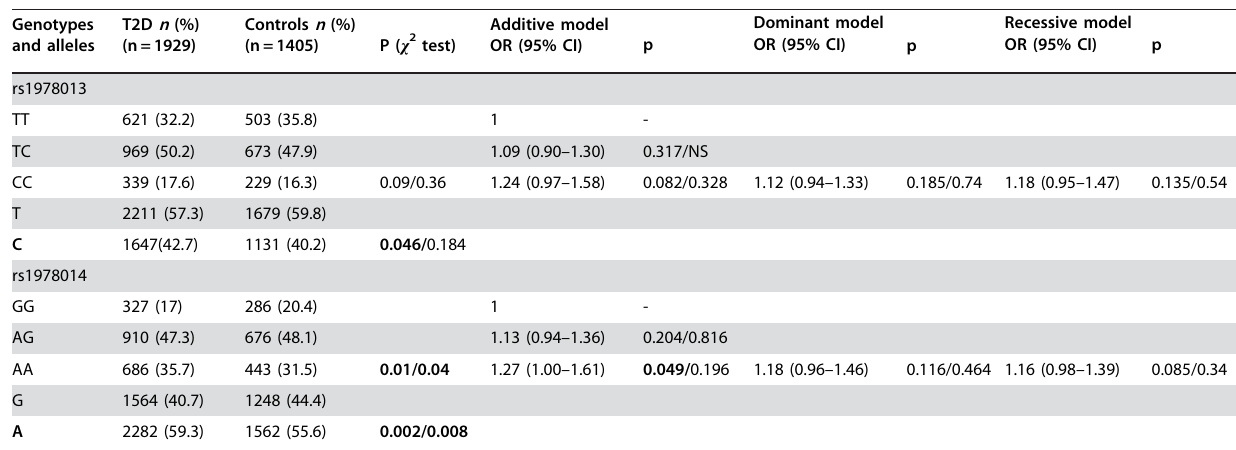
Legend to Table 2. Logistic regression results are adjusted for age, sex, BMI and family dependence. Both nominal and the Bonferroni-corrected p-values are shown. NS: not significant.